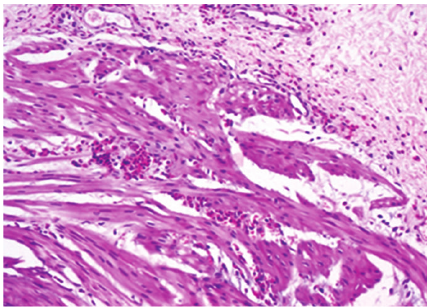
Figure 2: Eosinophilic infiltration into the right posterior muscle bundle (H&E ×